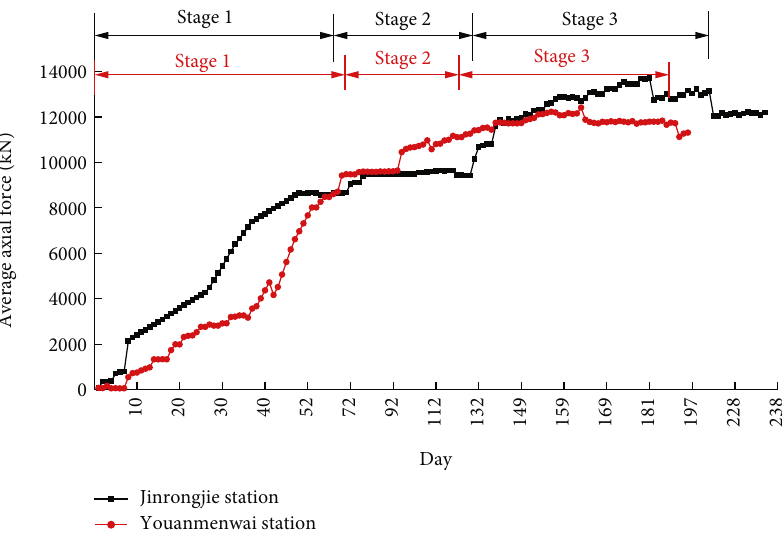
Figure 19: Time versus force curve of the pile foundation station.